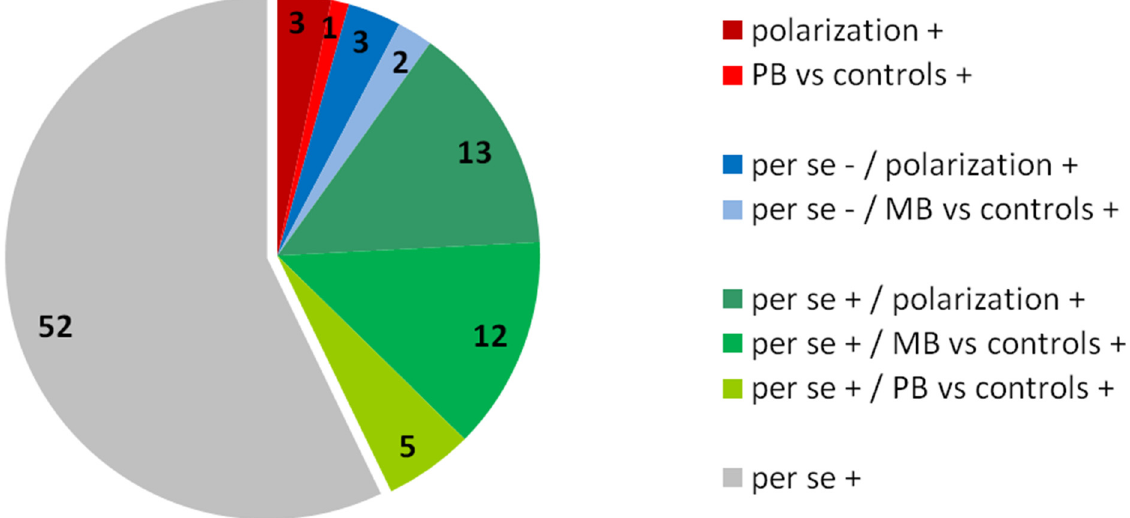
Fig 3. Distribution of 91 published associations between a genetic variant and leprosy per se, any leprosy subtype (i.e., MB or PB), or polarization. The + and – symbols refer to the presence or the absence of association of a given gene with one of the leprosy subtypes in the study. The red quadrant refers to studies for which the primary outcome was the association with leprosy polarization or the PB subtypes; the blue quadrant refers to studies that could not conclude an association with leprosy per se but did conclude an association with one of its subtypes; the green quadrant refers to studies that identified an association for both leprosy per se and one of its subtypes; and the grey quadrant refers to studies for which an association with only leprosy per se was